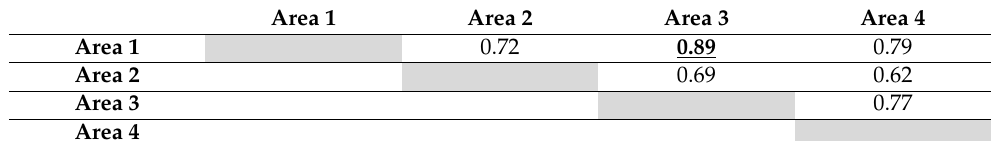
Table 5. Linear correlation coefficient of the four areas using the SARVI profiles.